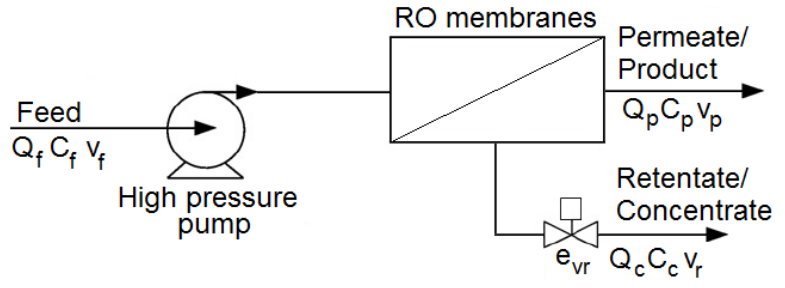
Figure 7. Diagram of an RO process used to obtain the